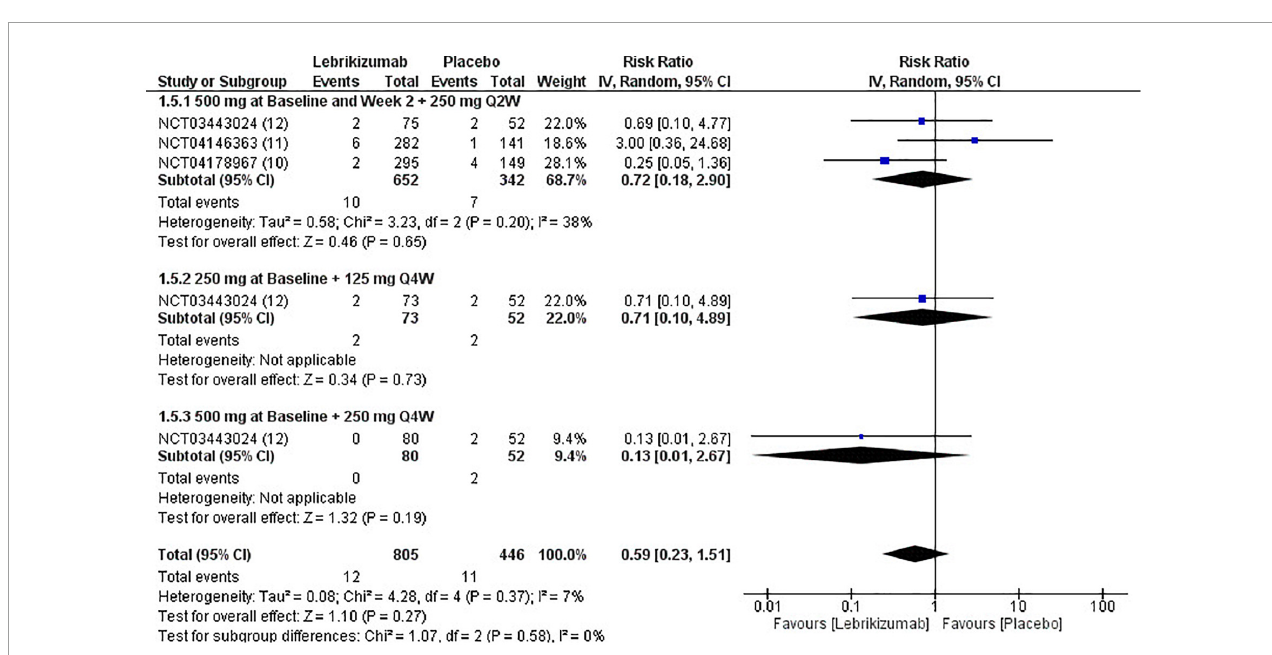
FIGURE9 Forest plot of SAEs. CI, confidence interval; IV, inverse variance; RR, risk ratio; Q2W, every 2 weeks; Q4W, every 4 weeks.